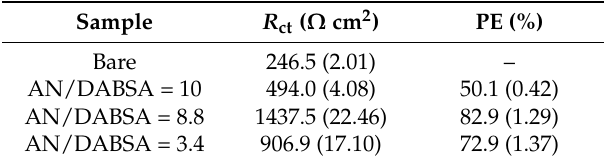
Figure 11. Nyquist plots of bare and SPAN-deposited mild steels with different AN/DABSA ratios in 1 M NaCl. Table 3. Charge transfer resistance ( R ct ) derived from EIS measurements (Figure 11) and protection efficiency (PE) of bare and SPAN-deposited mild steels with different AN/DABSA ratios in 1 M NaCl.